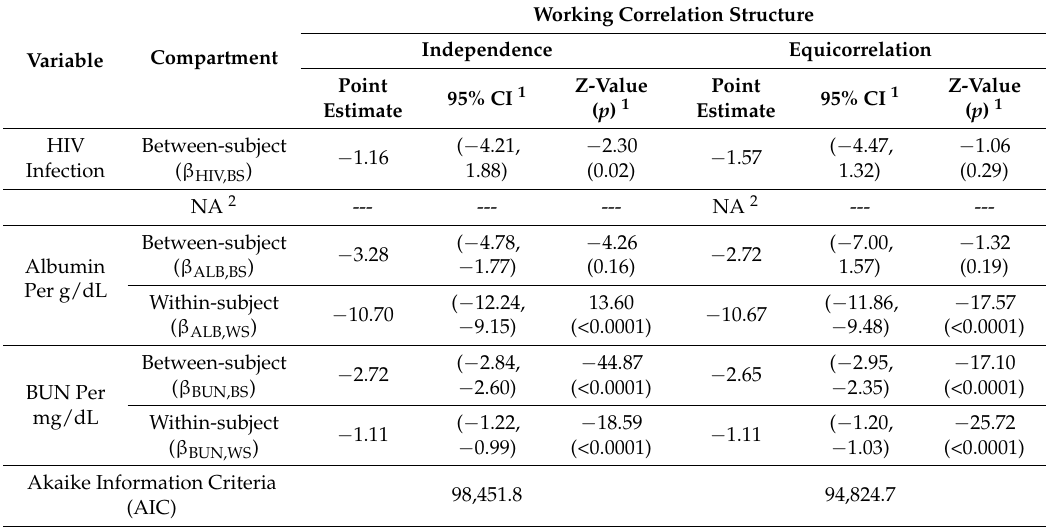
Table A2. Parameter estimates for the within- between-subject decomposition regression of Table 2 EGFR = HIV infection, albumin and BUN in the Bronx WIHS using mixed